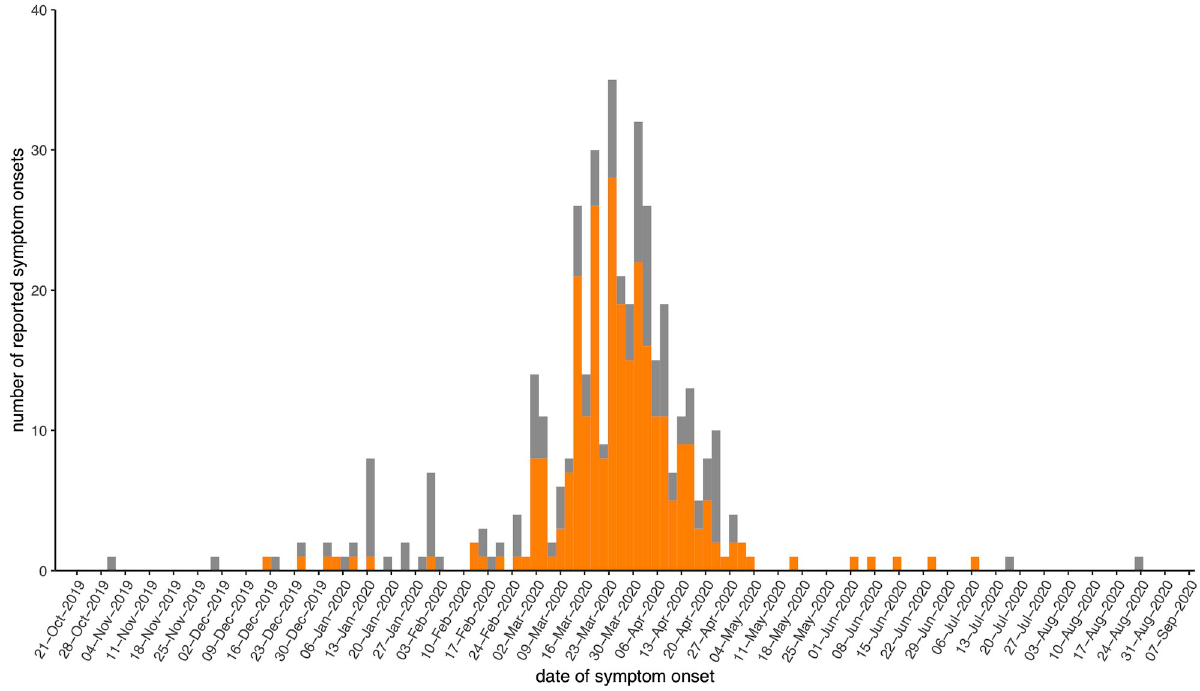
Fig 1. Dates of symptom onset according to COVID-19 status among the World Trade Center responder cohort in Long Island, NY between November 2019 and August 2020. Confirmed positive cases are shown in orange (N = 273), and unconfirmed cases are shown in gray (N = 129). Symptomatic cases confirmed to be negative for SARS-CoV-2 are not